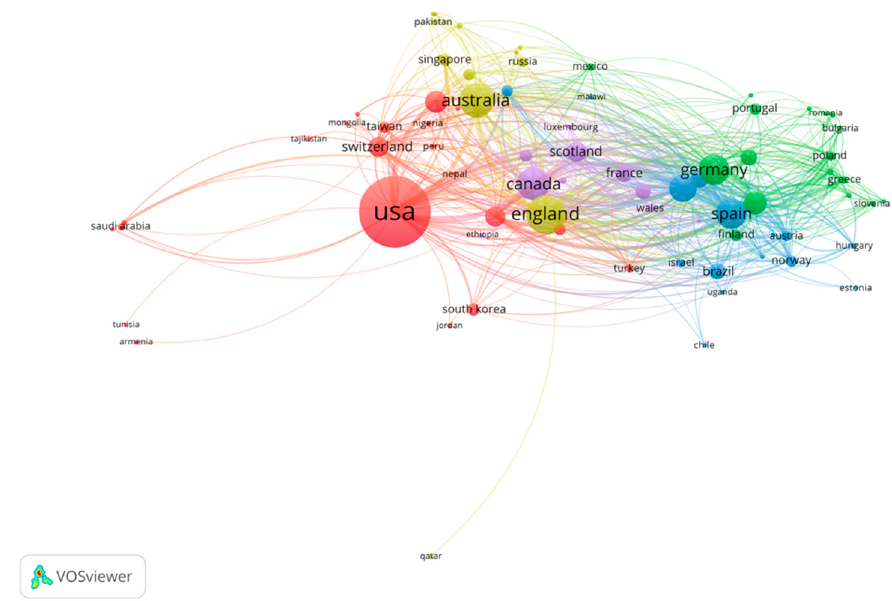
Figure 5. Co-countries analysis of global research.